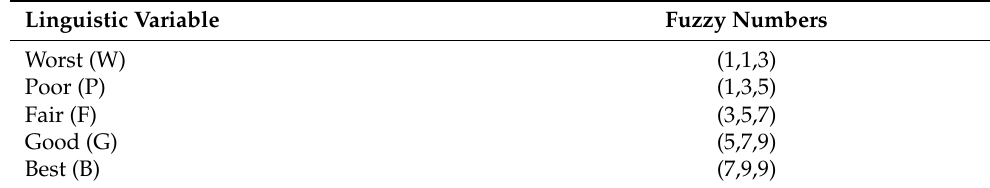
Table 6. Linguistic variables of the project alternatives [77].